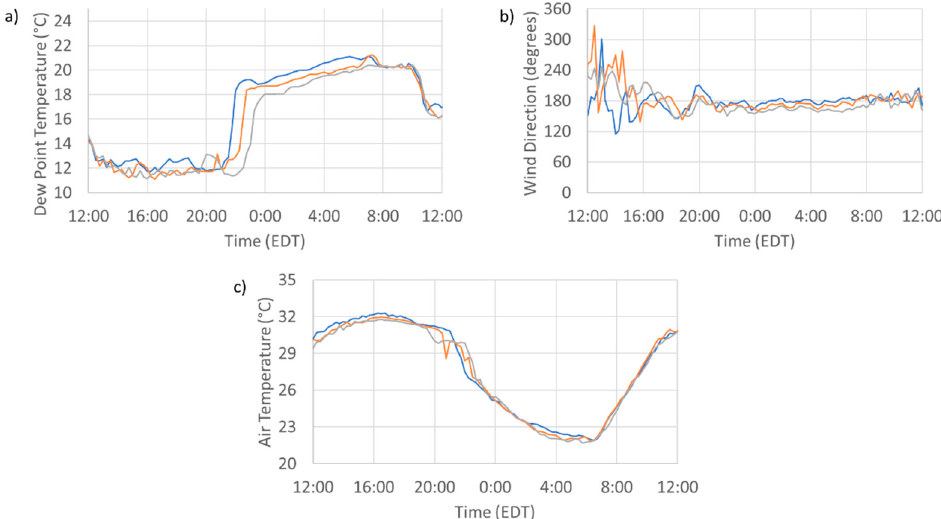
Figure 3. Depiction of 61 m ( a ) dew point temperature, ( b ) wind direction and ( c ) temperature on 22 May 2019 at MT1 (blue), MT2 (orange) and MT3 (gray).